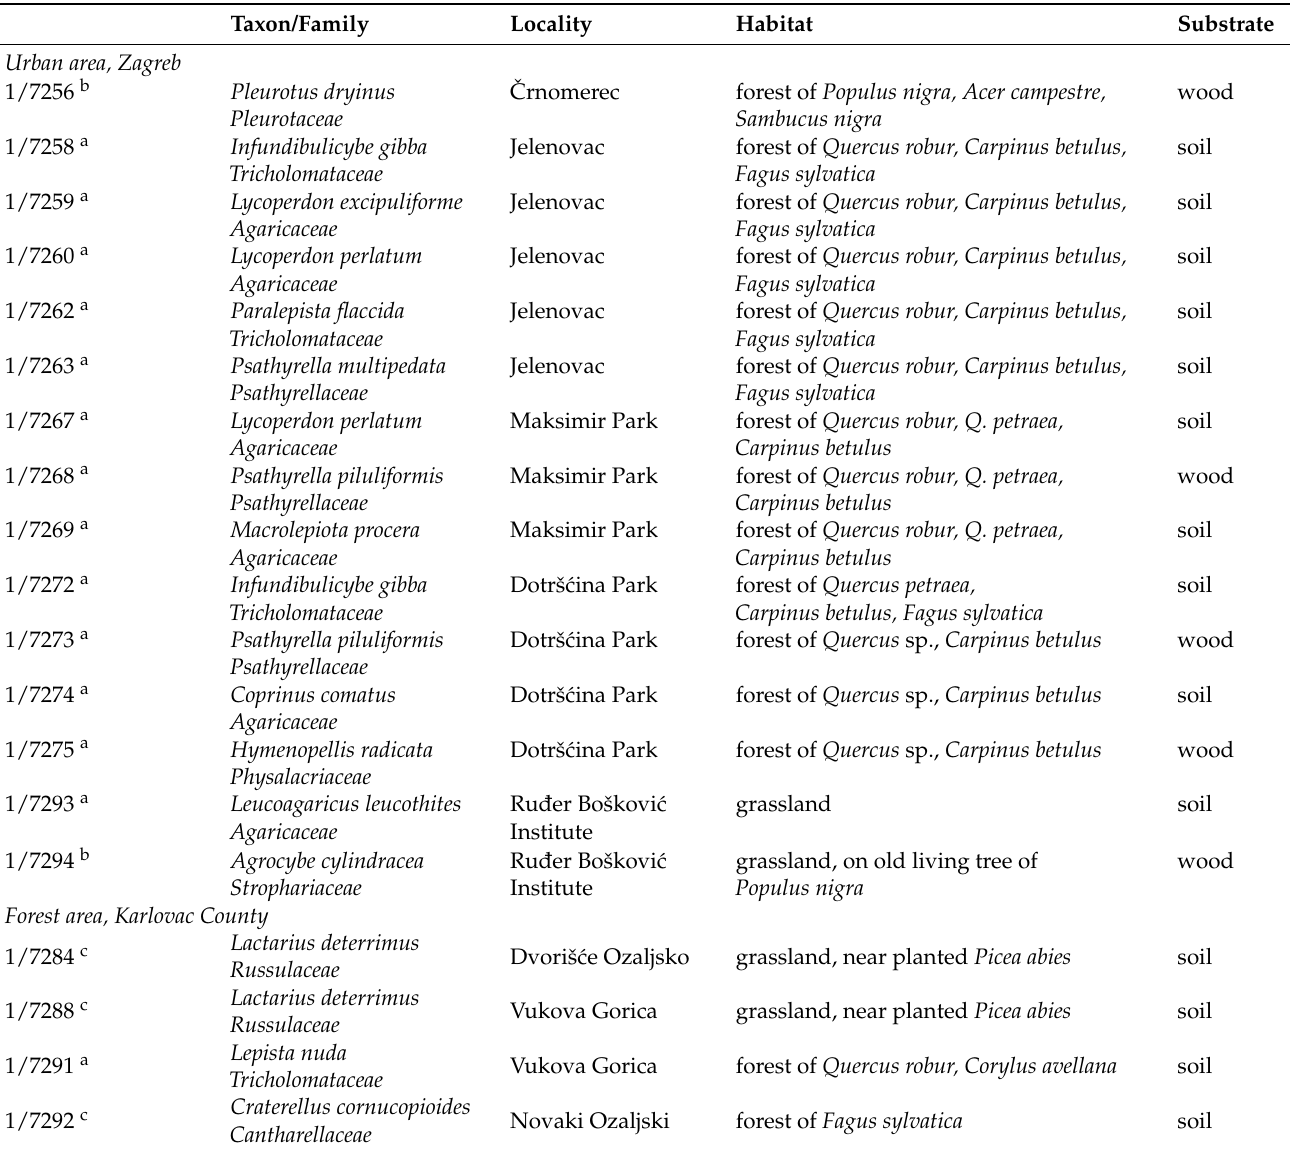
Table 1. Investigated species of mushrooms, and their lifestyle and location information. Trophic mode ( a saprotroph, b pathotroph/saprotroph or c